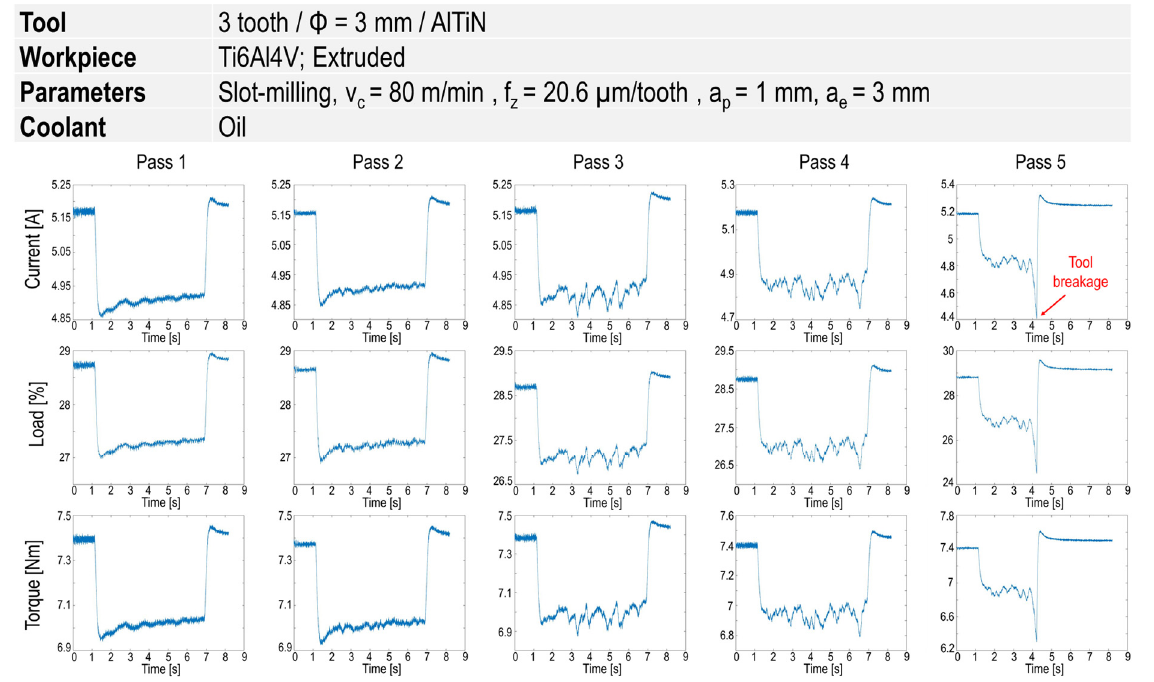
Figure 5. Signals of current, load and torque in different passes before tool breakage at v c = 80 m/min and f z = 20.6 µm/tooth.